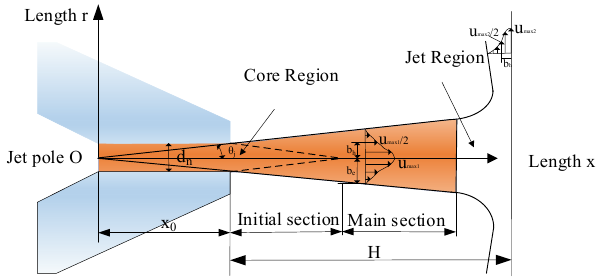
Figure 2. Jet flows schematic of free jet and wall impinging jet.